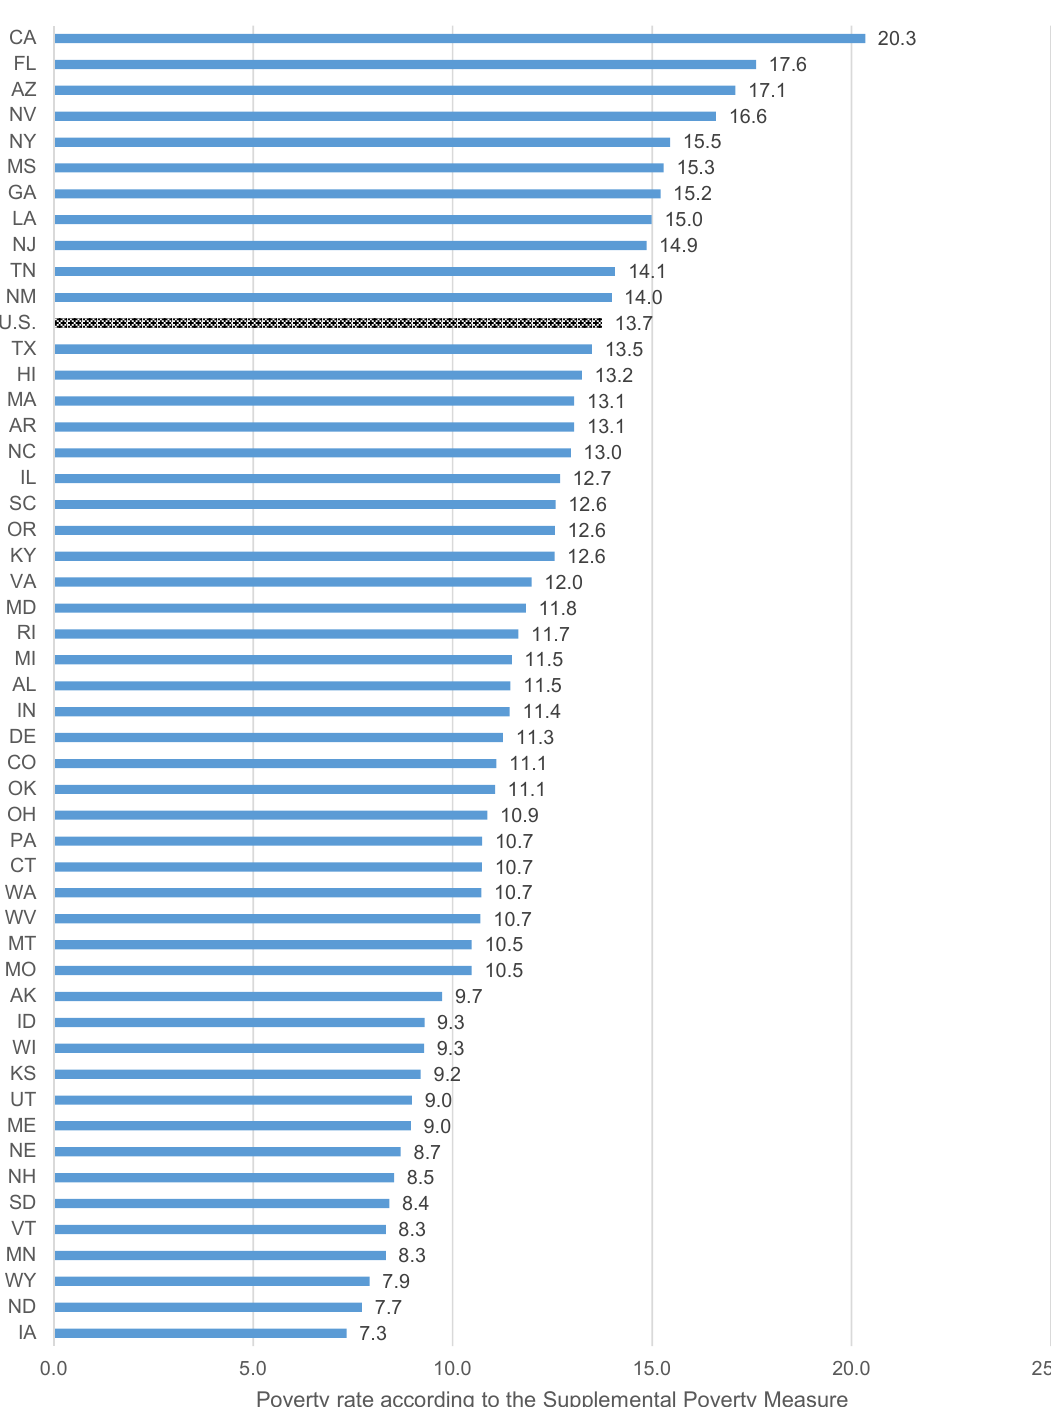
Figure 1. Poverty rates by state according to the SPM, adjusted for SNAP, SSI, and TANF under-reporting,